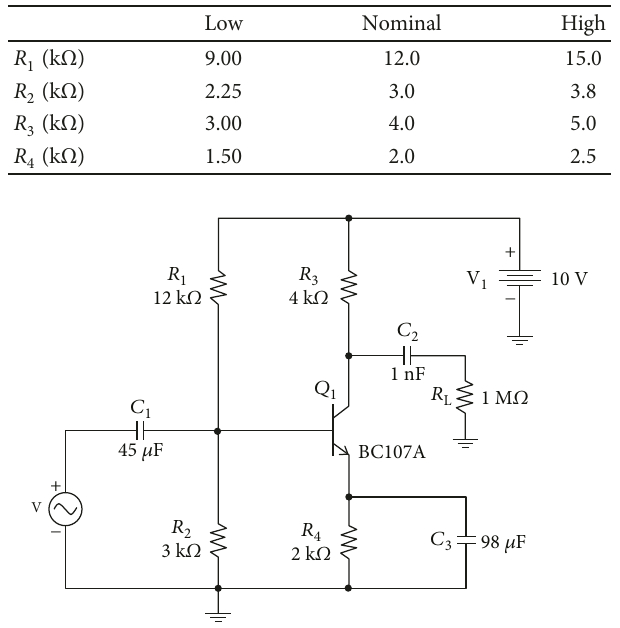
Table 1: Electrical resistance values.